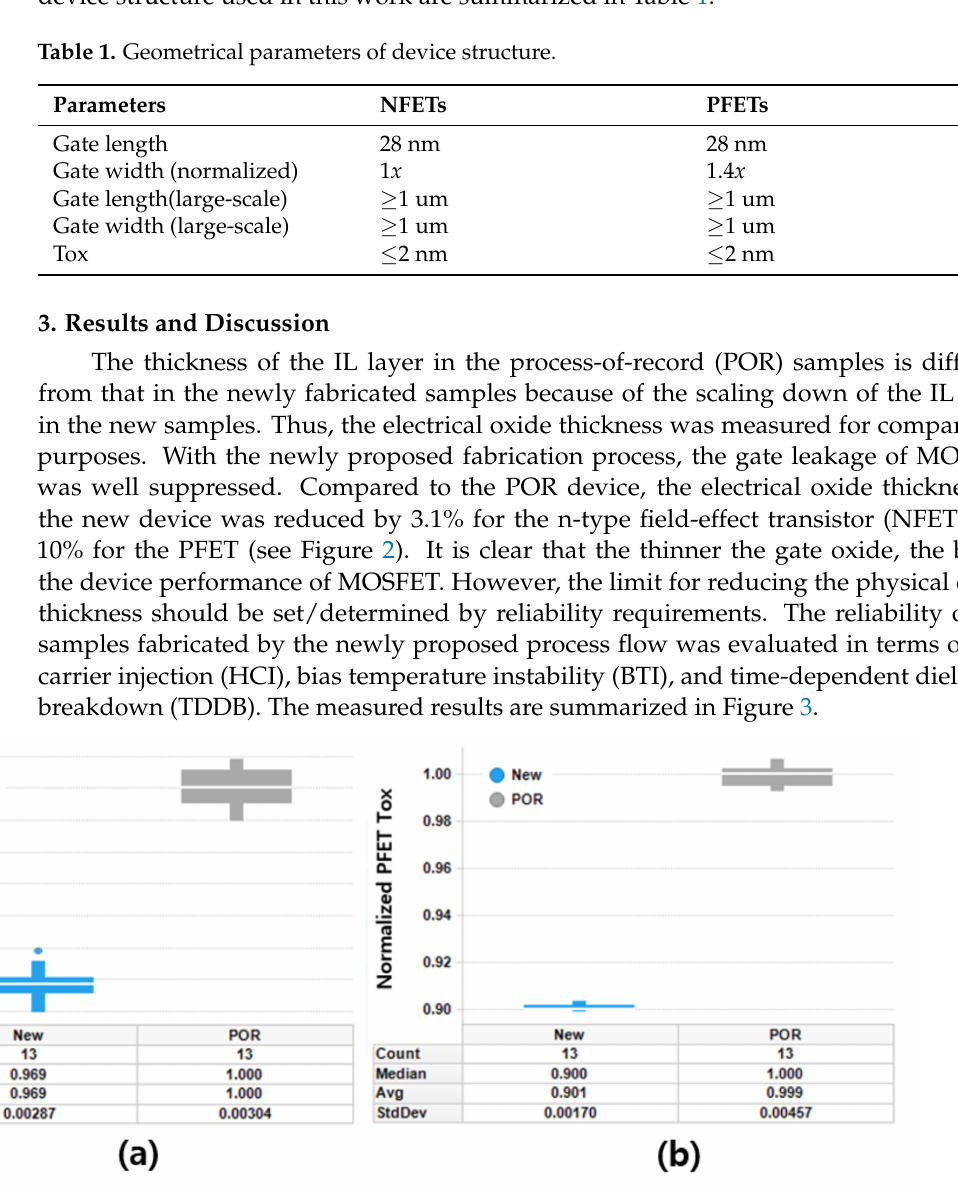
Figure 2. Normalized electrical oxide thickness of ( a ) n-type field-effect transistor (NFET) and ( b ) p-type field-effect transistor